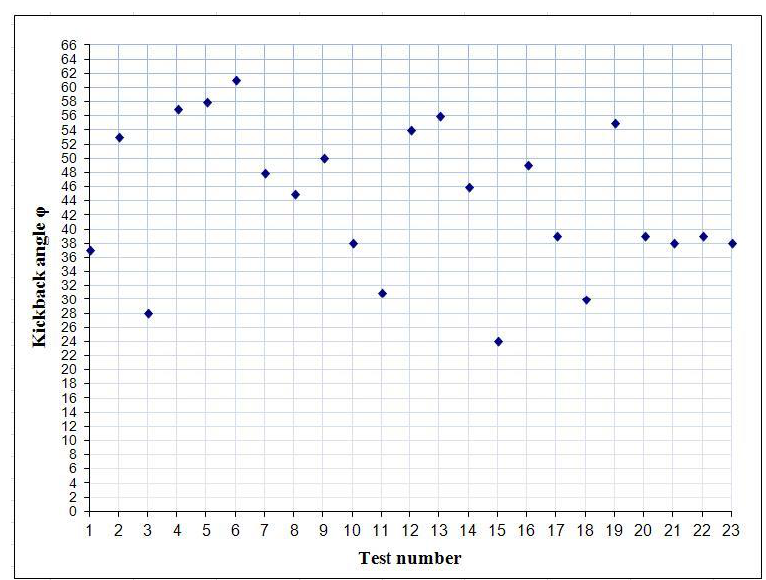
Figure 10. Changes in kickback angle, depending on the combination of chainsaws and cutting unit elements. Chainsaws: engine velocity: 150 s – 1 ; engine capacity: 40 cm 3 , 56 cm 3 , 59 cm 3 . Guide bars: length 400 mm, 500 mm, 600 mm (standard and reduced tip radius, sprocket nose or sliding guide bar). Chisel and semi-chisel saw chain type: with various tension levels on the guide bar, with anti-kickback or standard links, low-profile, or standard and with different cutting blade tilt angles and different depth gauge heights; maximum calculated final uncertainty of the kickback angle was ±2°.